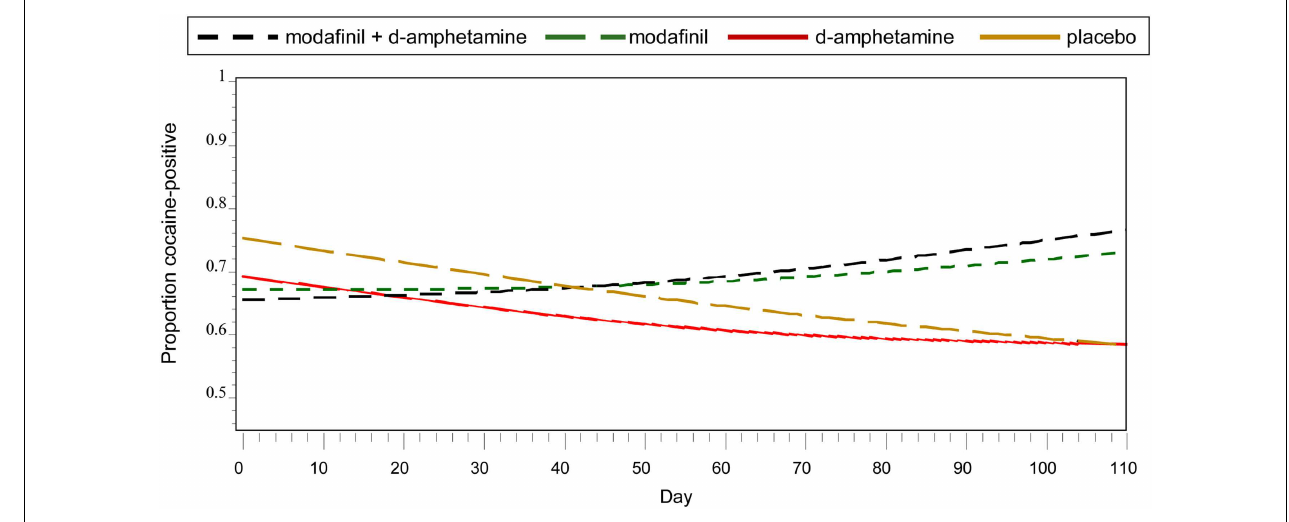
FIGURE 1 | Probability of cocaine use by medication condition and time.